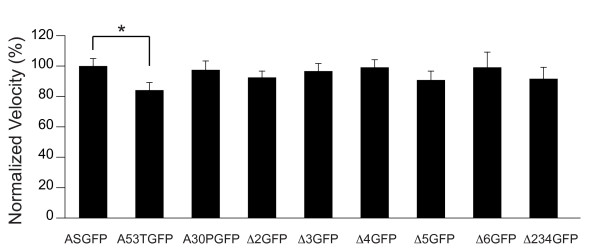
Velocity distribution for ASGFP and mutants. Velocities during periods of movement were calculated from kymographs, and mean ± SEM plotted as a percentage of ASGFP velocity. A53TGFP velocity was decreased relative to ASGFP (*p = 0.0033, pairwise t-test with Bonferroni correction; n>50 movies per group).